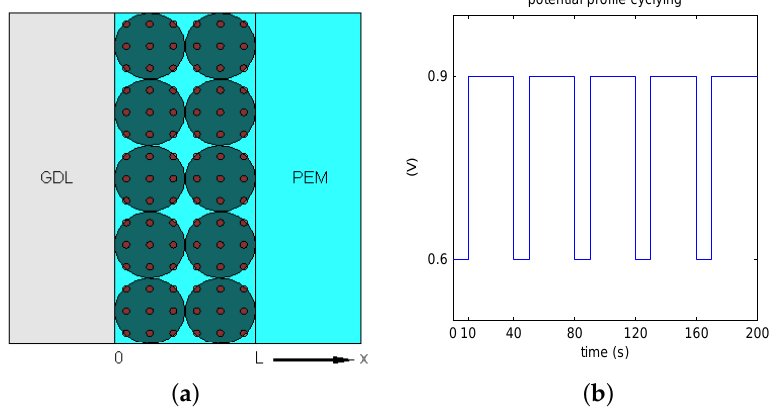
Figure 1. Sketch of the catalyst layer ( a ); five cycles of the electric potential cycling ( b ).